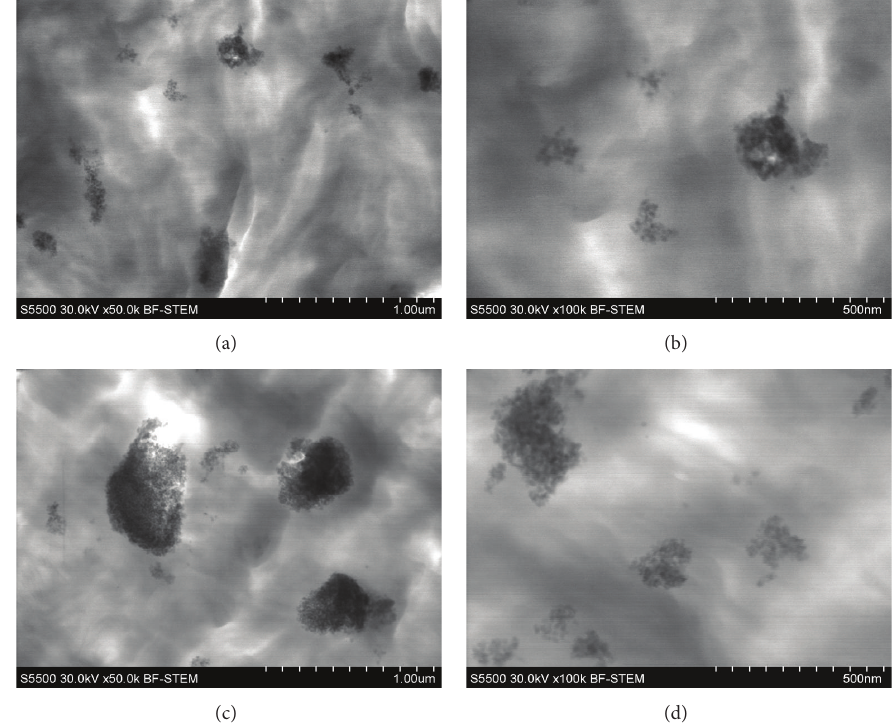
Figure 5: TEM images of HDPE/Cu-SiO 2 composites: 10wt.% Cu-SiO 2 ((a), (b)), 15 wt.% Ag-SiO 2 ((c), (d)).